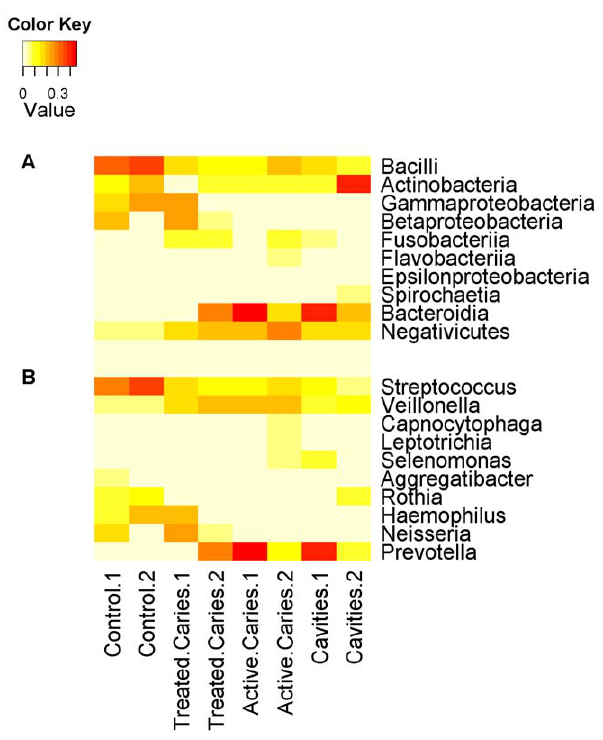
Figure S1 Barplot of the number of assigned reads by TAMER and MEGAN at rank Species for simHC data.